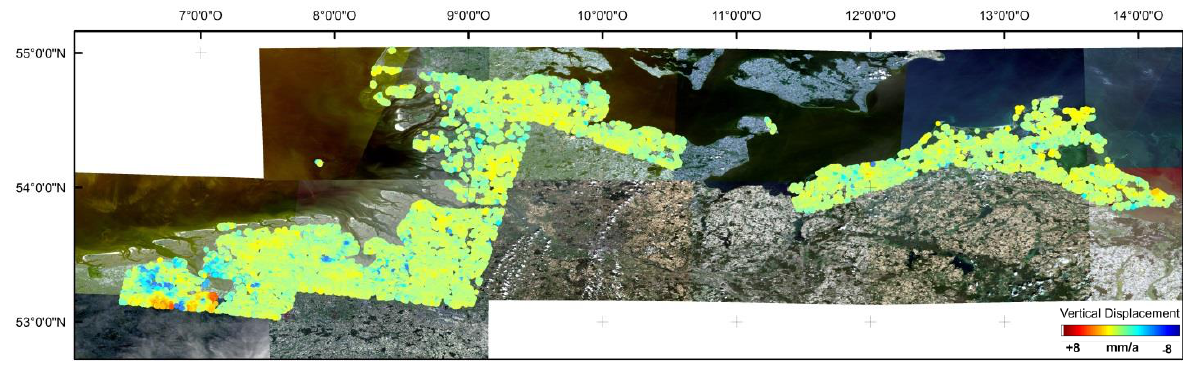
Figure 2: Results from PSI for the North Sea and Baltic Sea coast in Germany and north-eastern part of the Netherlands overlaid on Sentinel-2 data.